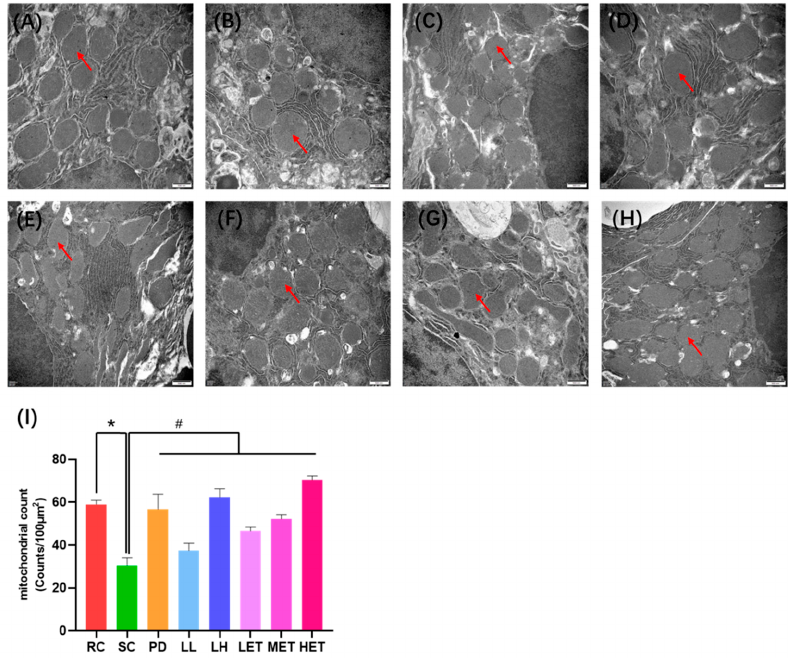
Figure 10. Transmission electron microscopy analysis of hepatocytes. ( A ) RC, ( B ) SC, ( C ) PD, ( D ) LL, ( E ) HL, ( F ) LET, ( G ) MET, ( H ) HET, ( I ) Mitochondrial count. Data are expressed as mean ± SD, N = 3, Magnification × 30,000. *: vs. RC p < 0.05, #: vs. SC, p < 0.05. Mitochondria are shown by red arrows.